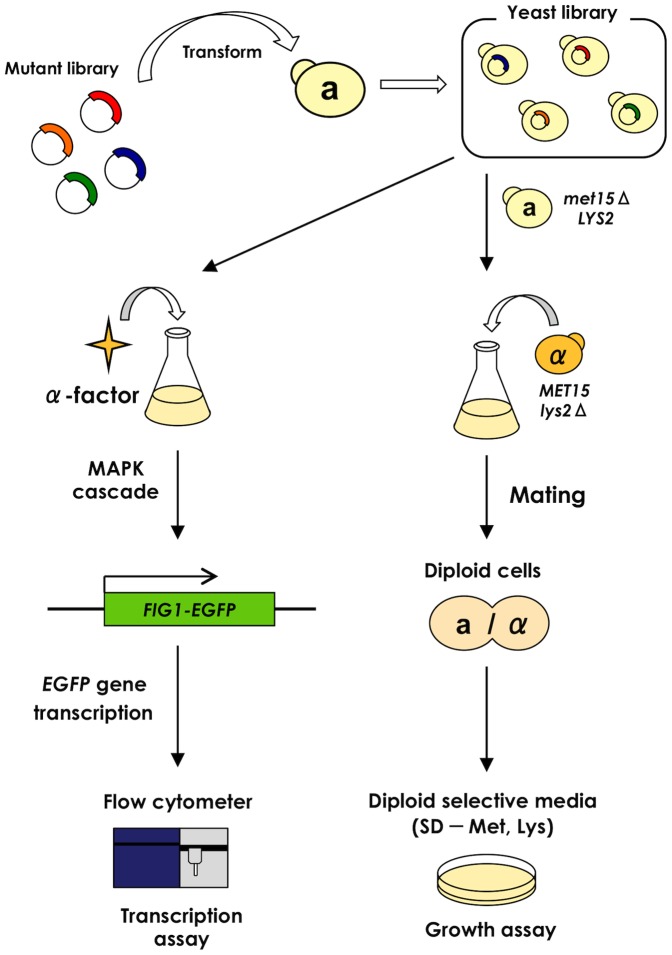
Flow diagram of the screening procedure for the competitive Gγ recruitment system.Two selection methods are available to screen affinity-altered proteins. One is to use the GFP reporter gene. When target candidate proteins are expressed in the yeast cells and interact with each other, they induce GFP expression and are isolated by flow cytometry. Another method is to use yeast mating detected using a growth assay. When target candidate proteins are expressed in yeast cells, they restore mating ability and grow on the diploid-selective medium.